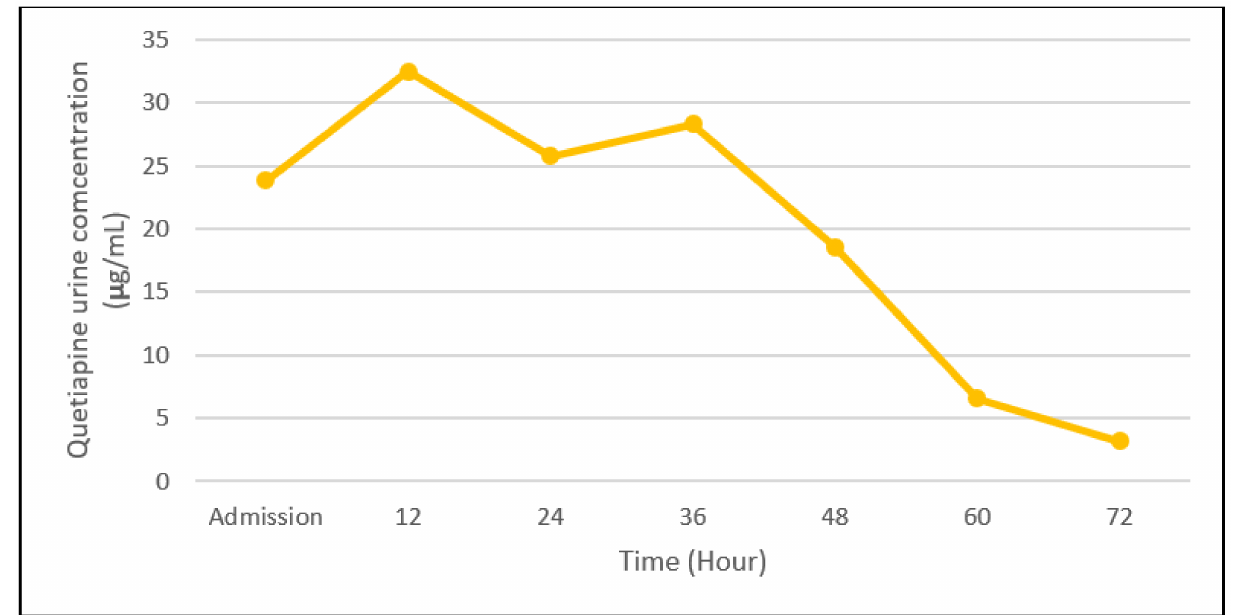
Figure 2. Urine time-related concentration of Quetiapine.